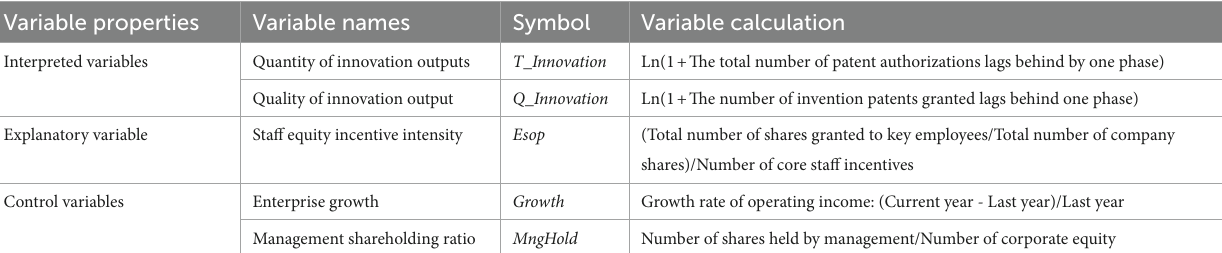
TABLE 6 Definition of alternative